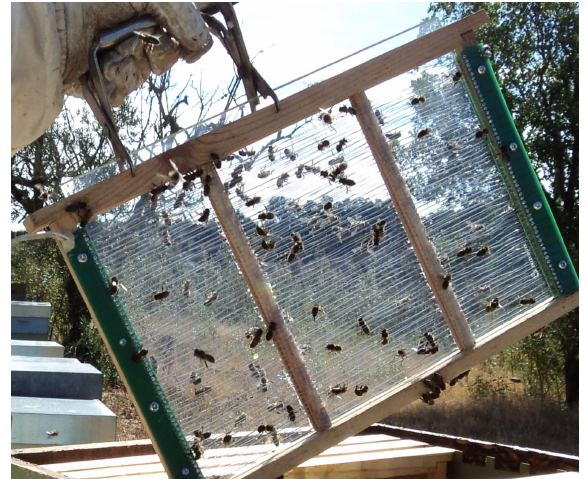
Figure 6. Equipment Application in Real